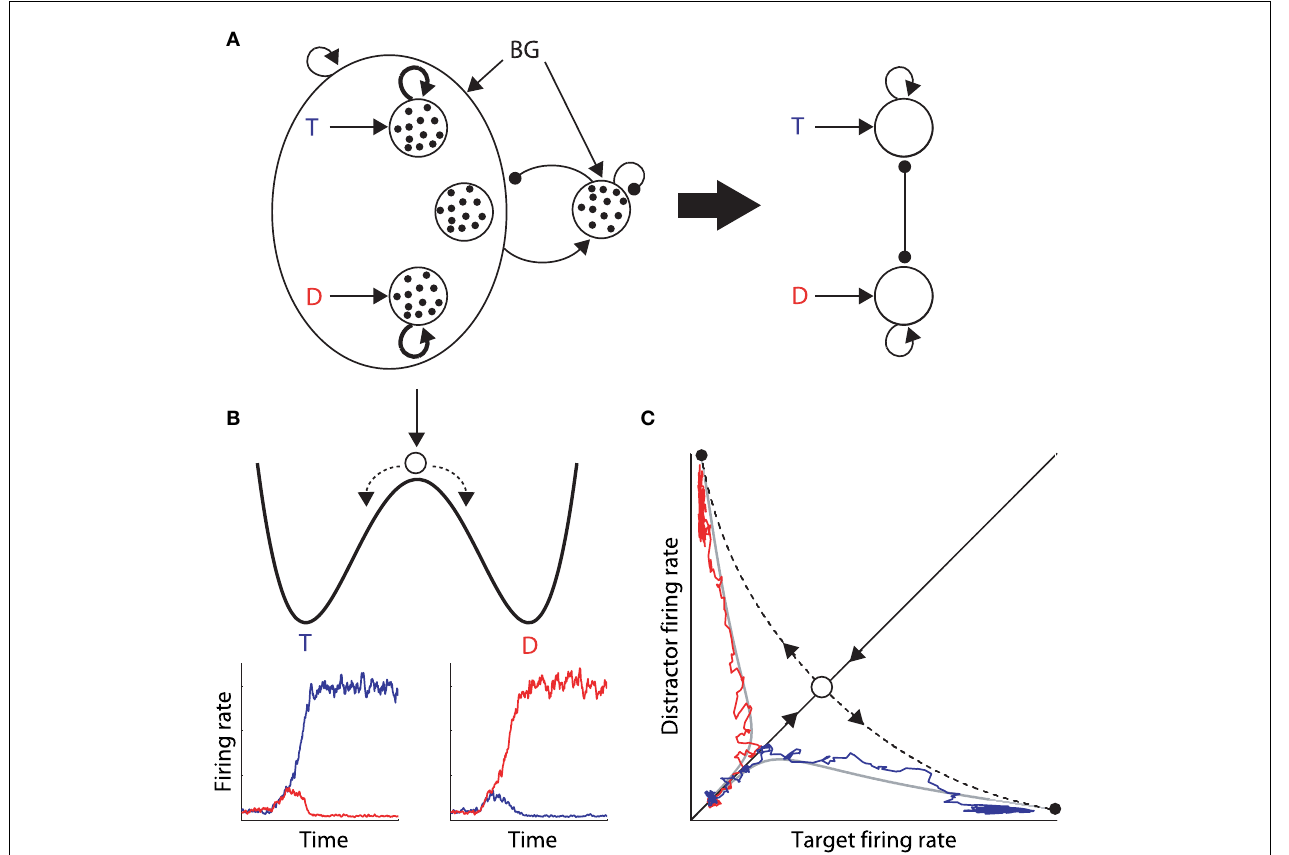
FIGURE 1 | (A) The reduced model by Wong and Wang (2006), approximating a biophysically-based cortical network model (left of the thick arrow) with a 2-variable system (right). The thick arrow depicts the derivation of the latter from the former. The large oval on the left depicts a network of cortical pyramidal neurons. Inside the oval, the three open circles depict the target and distractor populations with selective input T and D respectively, and a population unresponsive to the evidence for either alternative. Looping arcs depict recurrent synapses, which are stronger within each selective population (thicker arcs). All pyramidal neurons excite a common inhibitory pool, which uniformly inhibits all pyramidal neurons. Excitatory and inhibitory synapses are depicted by arrows and closed circles respectively, small black dots depict individual neurons, and BG refers to background input. (B) Cartoon depiction of an attractor “energy landscape” for 2-choice decisions, where the energy decreases over time. An unstable steady state (high energy) separates two stable attractors (low energy), corresponding to the target and